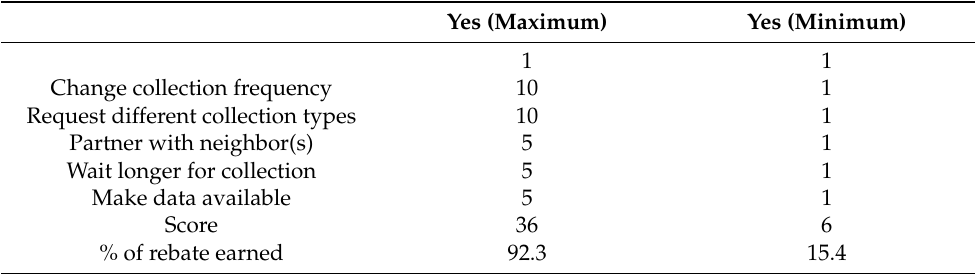
Table 8. Maximum and minimum possible scores when participating in